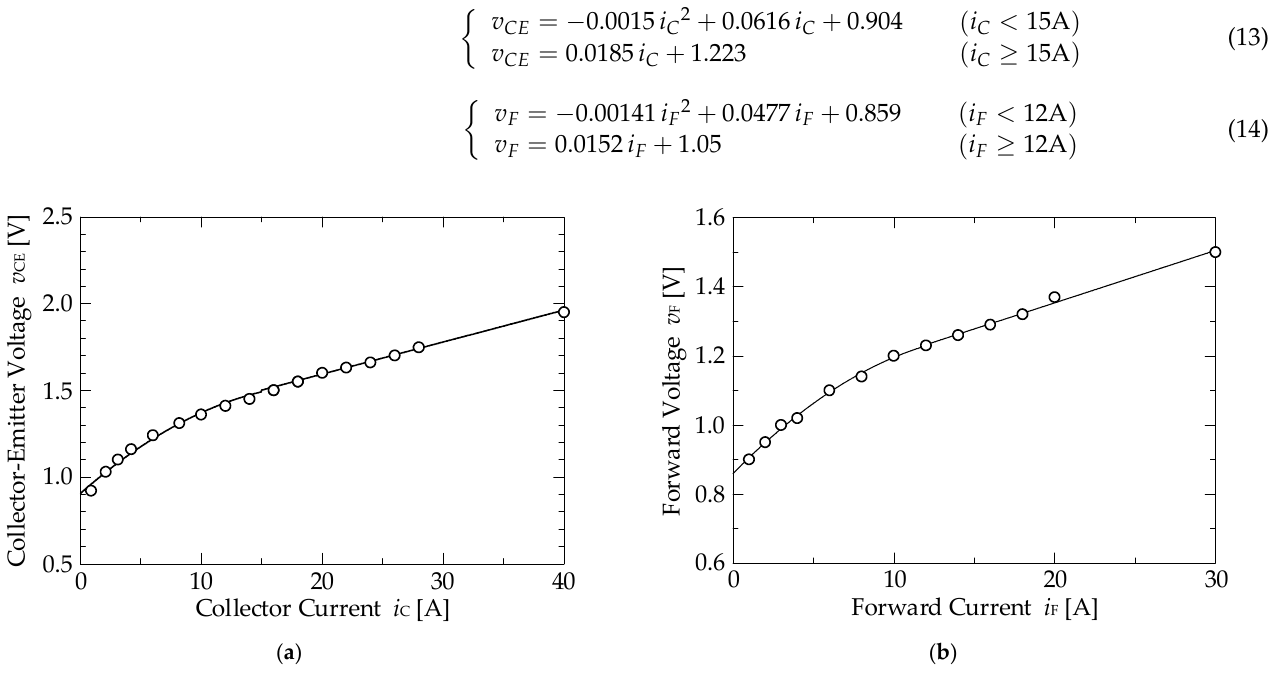
Figure 10. Current and voltage characteristics of IGBT and diode. ( a ) IGBT for S 1 and S 2 . ( b ) Diode for D S1 and D S2 .